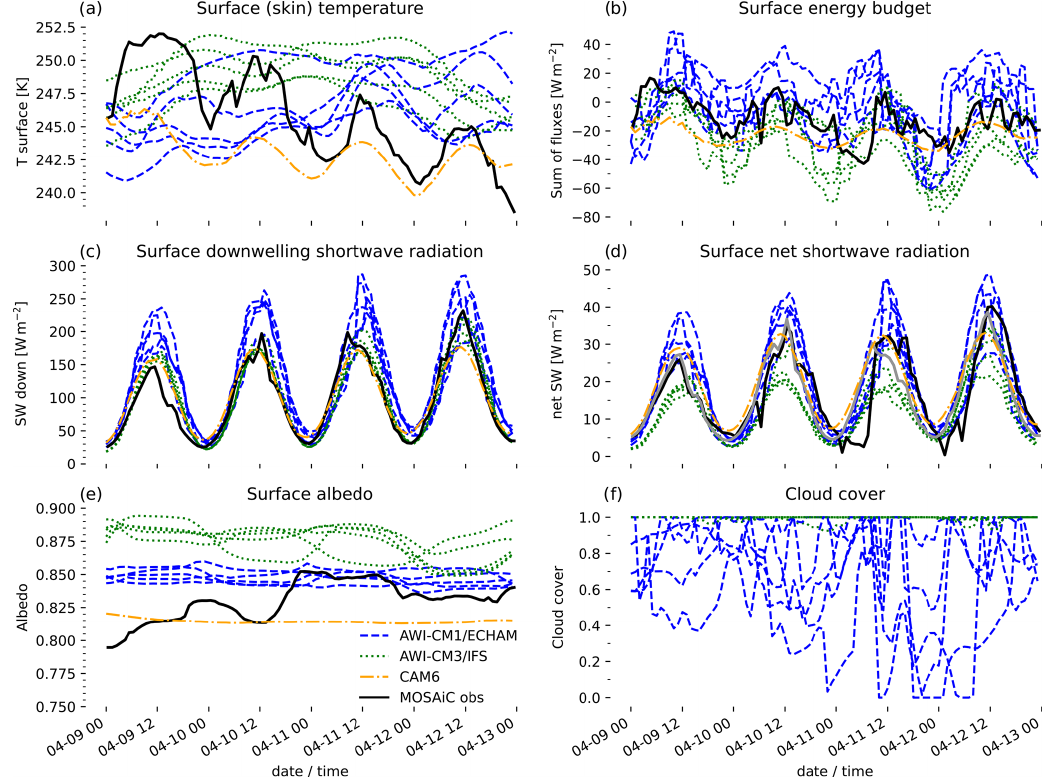
Figure 3. Observed and modelled skin temperature, surface energy budget, shortwave fluxes, albedo and cloud cover for 9 to 12 April 2020, the cold period prior to the moist intrusion. Blue dashed lines show AWI-CM1/ECHAM, green dotted lines show AWI-CM3/IFS and orange dash-dotted lines show CAM6 results. Observations are shown by a black solid line, and the grey line in panel (d) shows an estimate of net shortwave radiation using a time-averaged albedo (see text). Cloud cover was not output for the CAM6 runs analysed